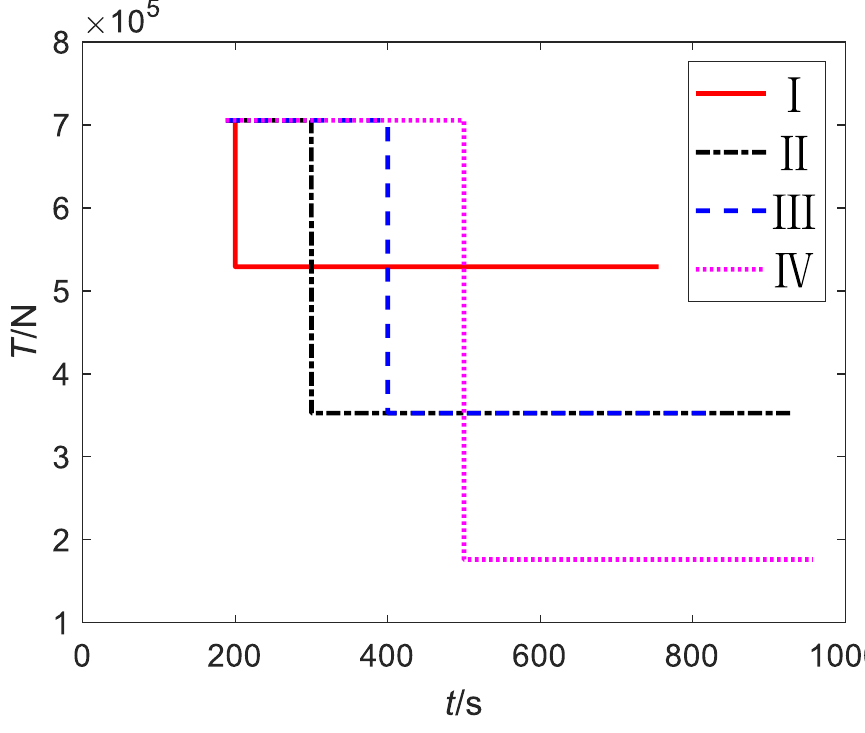
Figure 7. Engine Figure 7. Engine thrust.